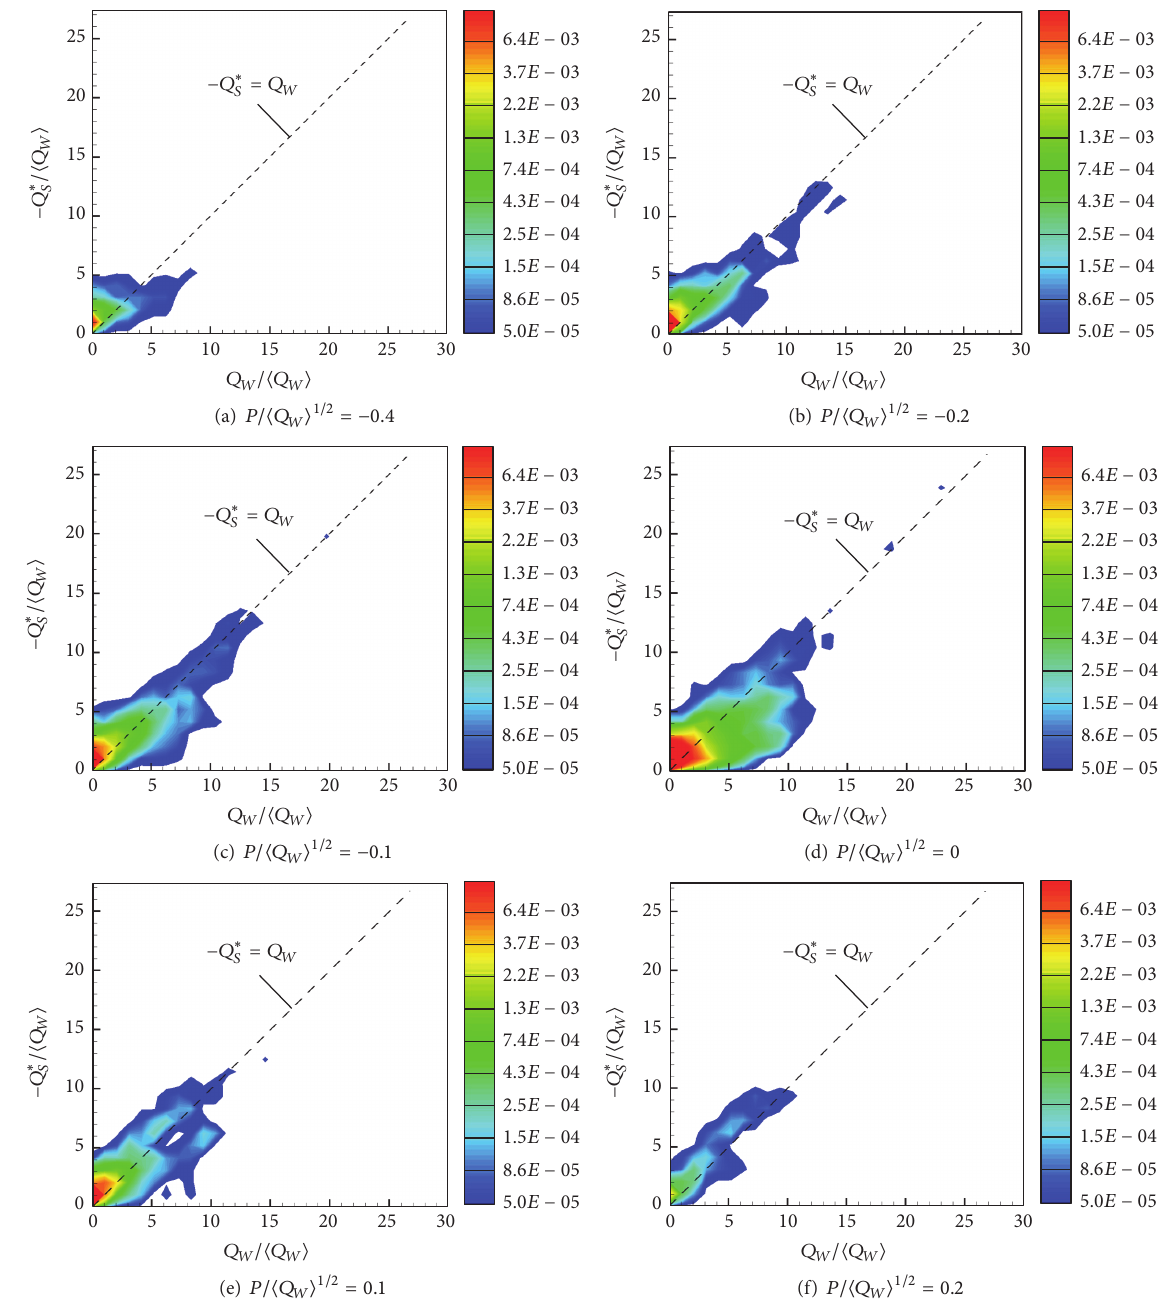
Figure 11: Joint p.d.f. of 𝑄 ∗ 𝑆 - 𝑄 𝑊 invariants in the flame zone at 𝑡 = 189 𝜇